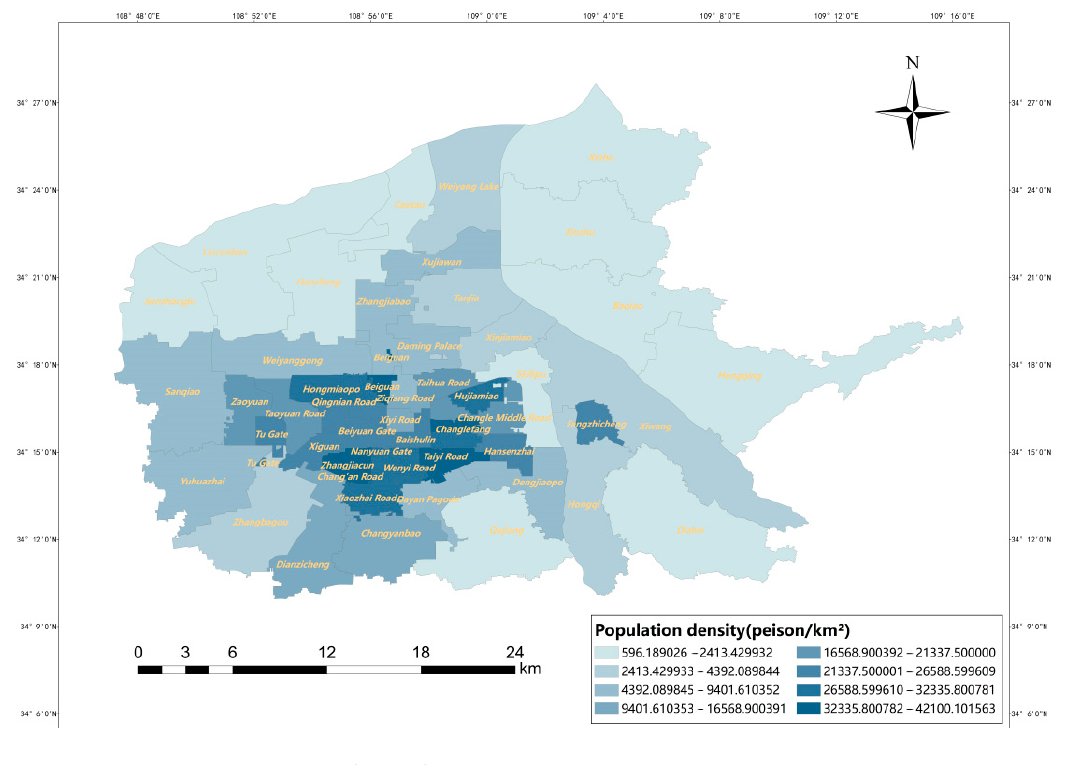
Figure 4. Population density.